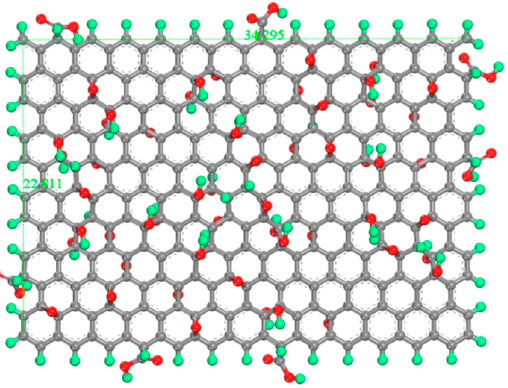
Figure 2. Molecular models for GO. The green atom is H, the gray atom is C, and the red atom is O.